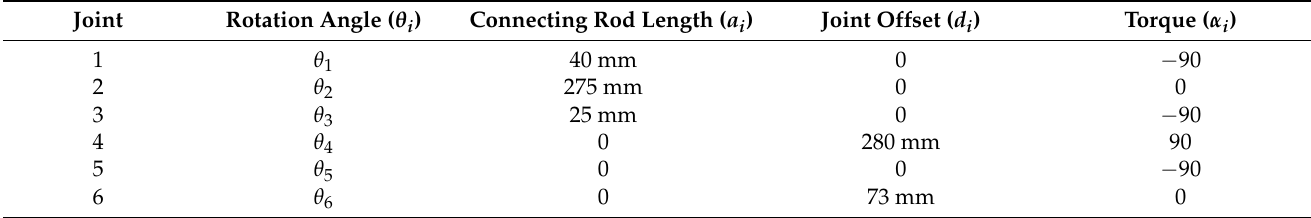
Figure 8. Two-arm cooperation robot’s D-H coordinate system. Table 1. ROKAE XB-4 D-H parameters.